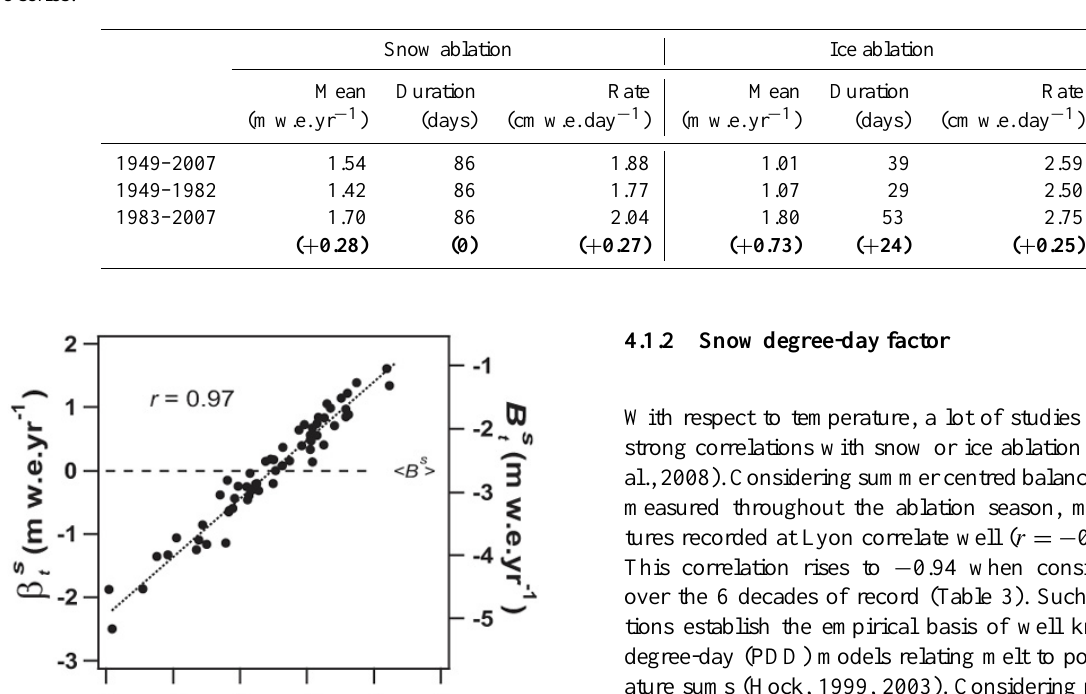
Table 5. Amount, duration and rate for snow and ice ablation at Sarennes over the whole period of record as well as before and after the breakpoint identified by the analysis of variance. Bold face values are differences after the 1982 breakpoint identified in the summer balance time series.